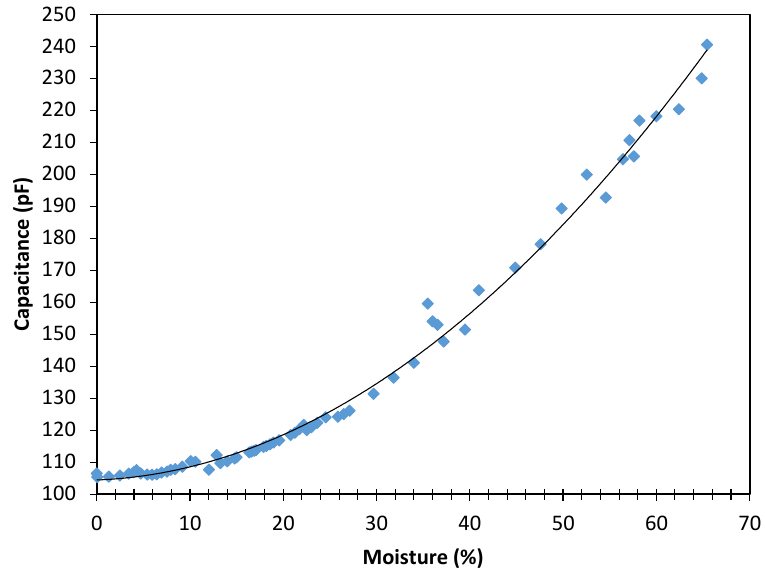
Figure 3. Relationship between capacitance (pF) and moisture content (% according to the standard) of a sample of wood from a building under restoration.